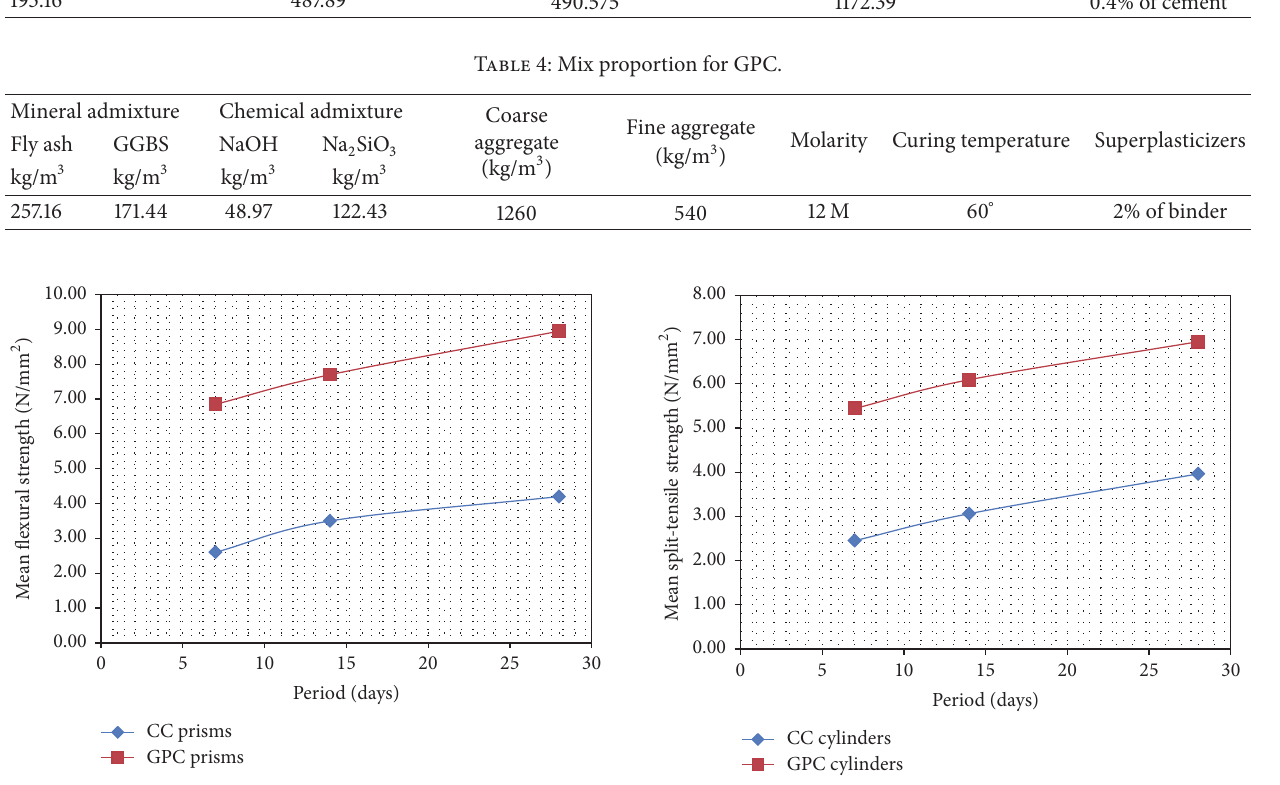
Figure 2: Flexural strength developments. Figure 3: Split-tensile strength